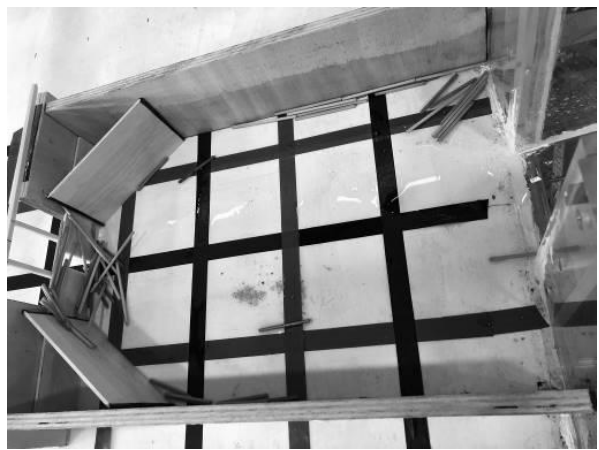
Figure 15. Wood debris control/capture status.